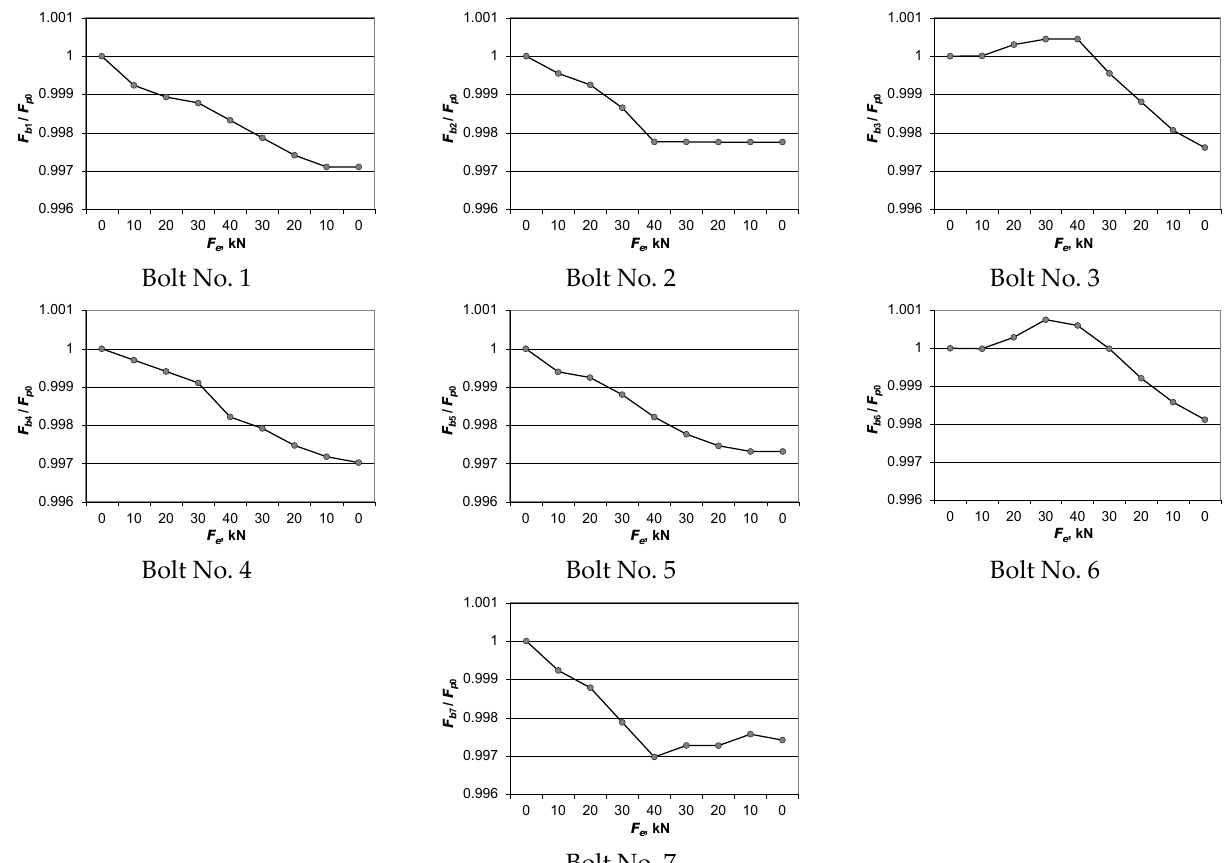
Figure 7. Distributions of the bolt forces as a function of the exploitation loads. Multi-bolted connections are nonlinear systems of many bodies in contact. As a result, even in a preloaded multi-bolted connection, the load added in the exploitation state affects its stiffness characteristics and thus the change in bolt forces. When the connection is loaded, the unevenness in the contact joints occurring in the multi-bolted connection is levelled, so that the forces in the bolts are most often reduced. Unloading the connection further lessens these forces. The variability in the bolt forces is smaller in the case of multiple instances of loading and unloading of the connection. The results of research on this subject will be published in our next paper.